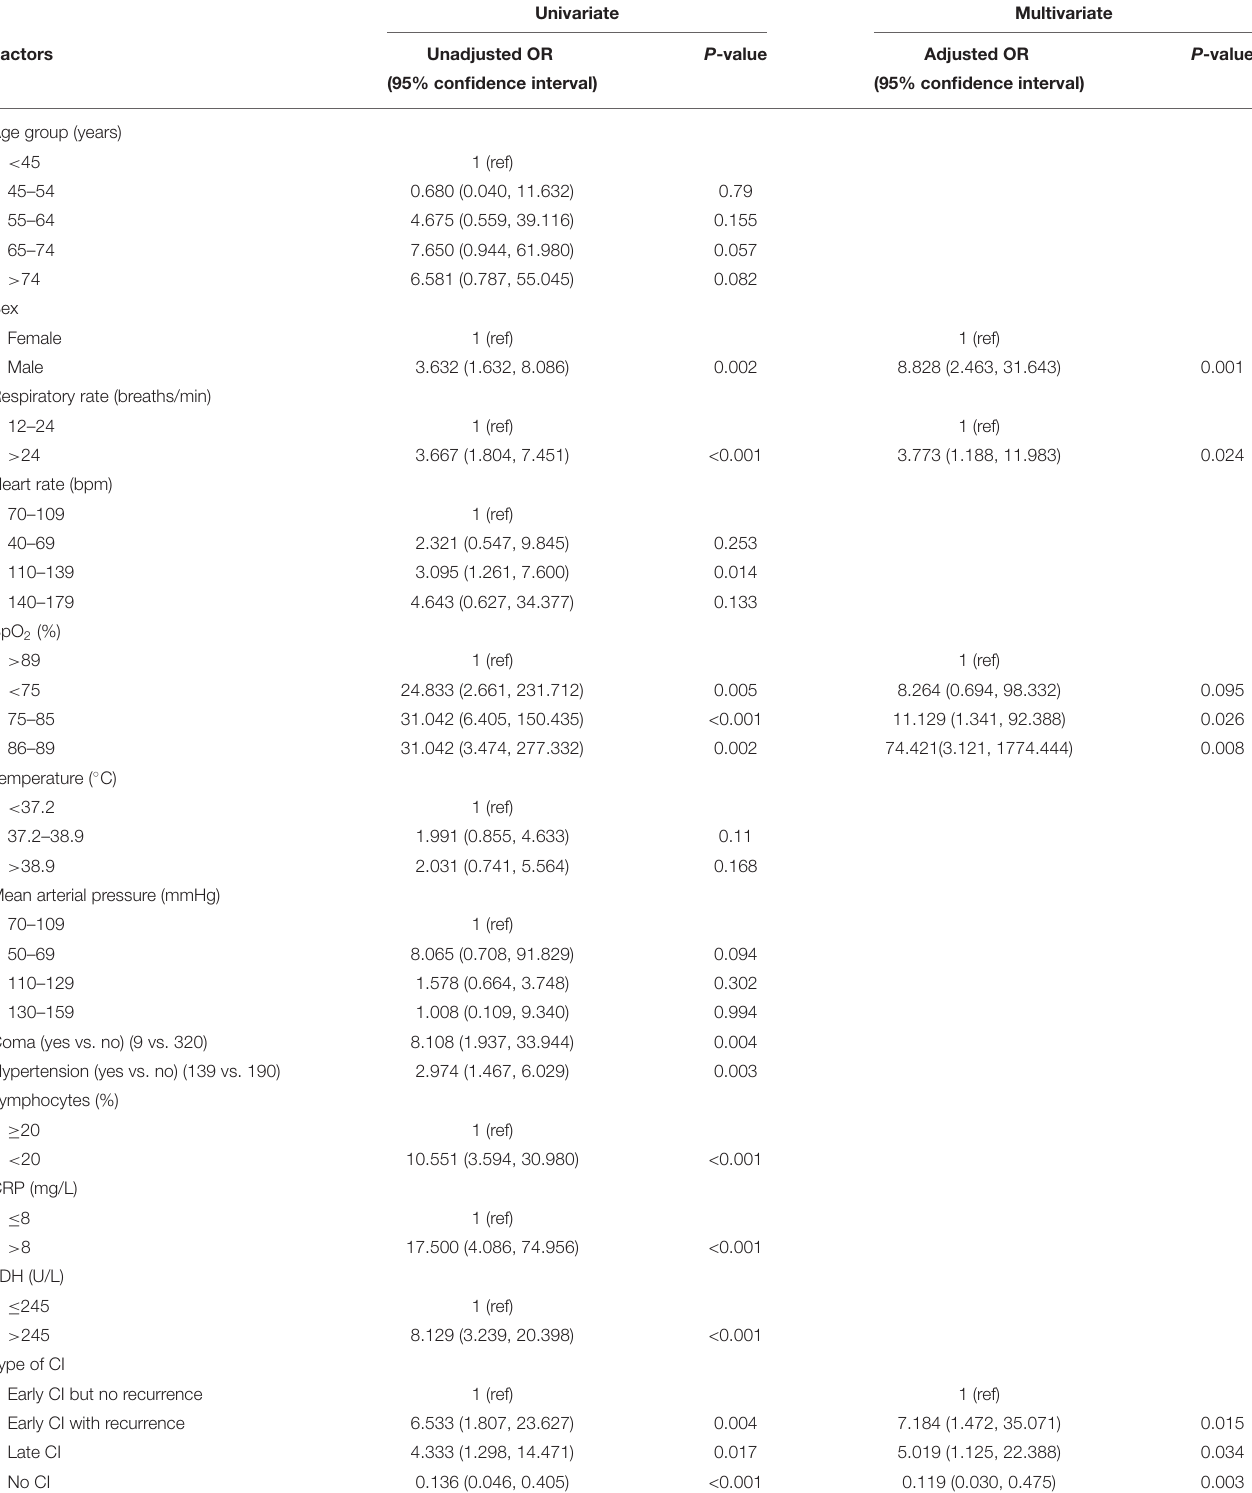
TABLE 3 | Univariate and multivariate logistic regression analysis of factors associated with in-hospital mortality of COVID-19 patients. Univariate Multivariate Factors Unadjusted